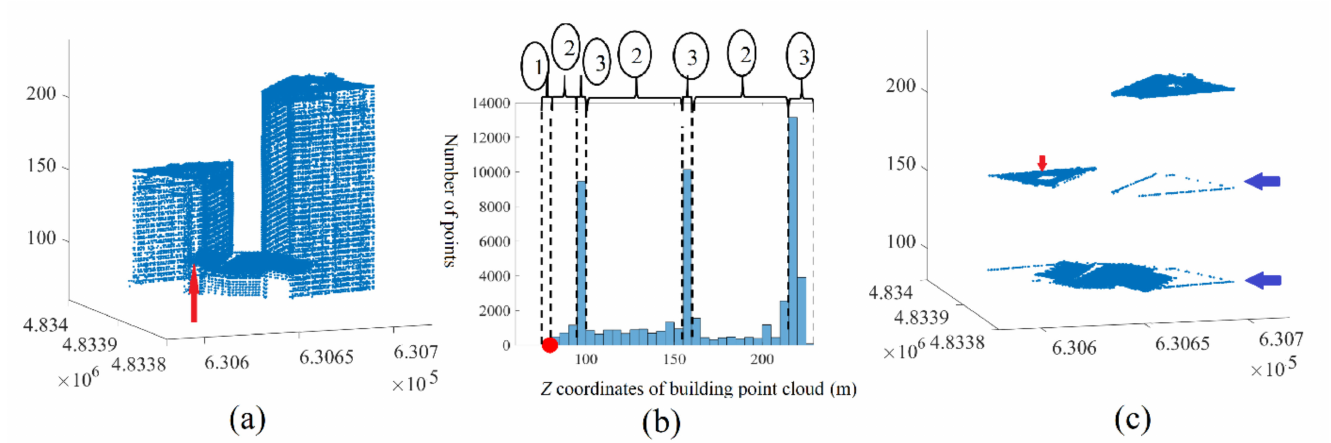
Figure 13. ( a ) Building point cloud in Toronto dataset; ( b ) histogram of Z coordinate of building point cloud; ( c ) final result of building point cloud filtering; the red dot in ( b ) is PSTF; the blue arrow in ( c ) façade points that are saved; the red arrow in ( c ) the missed small and low plane; “1,2,3” in circles in ( b ) are building section